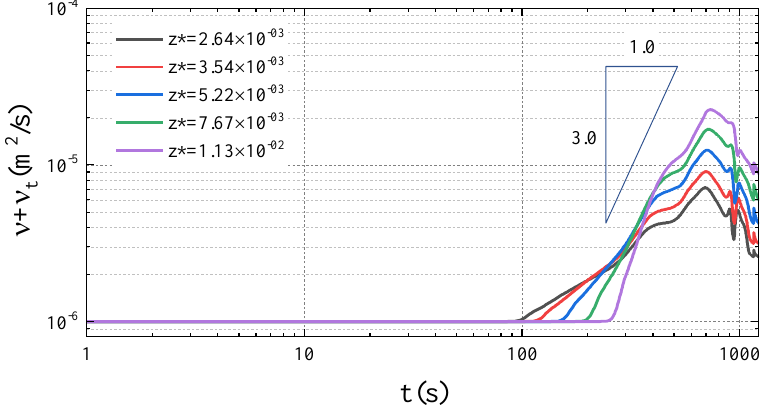
Figure 6. Time variation of the total molecular viscosity and eddy viscosity at several elevations near the bottom.